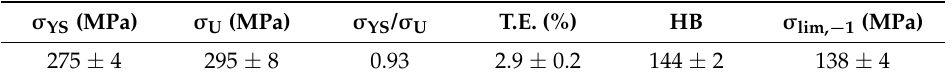
Table 3. Monotonic tensile (based on four replicated tests) and rotating bending fatigue (from the staircase tests data listed in Table 4) properties of the present material. Standard error corresponds to 1σ uncertainty band.